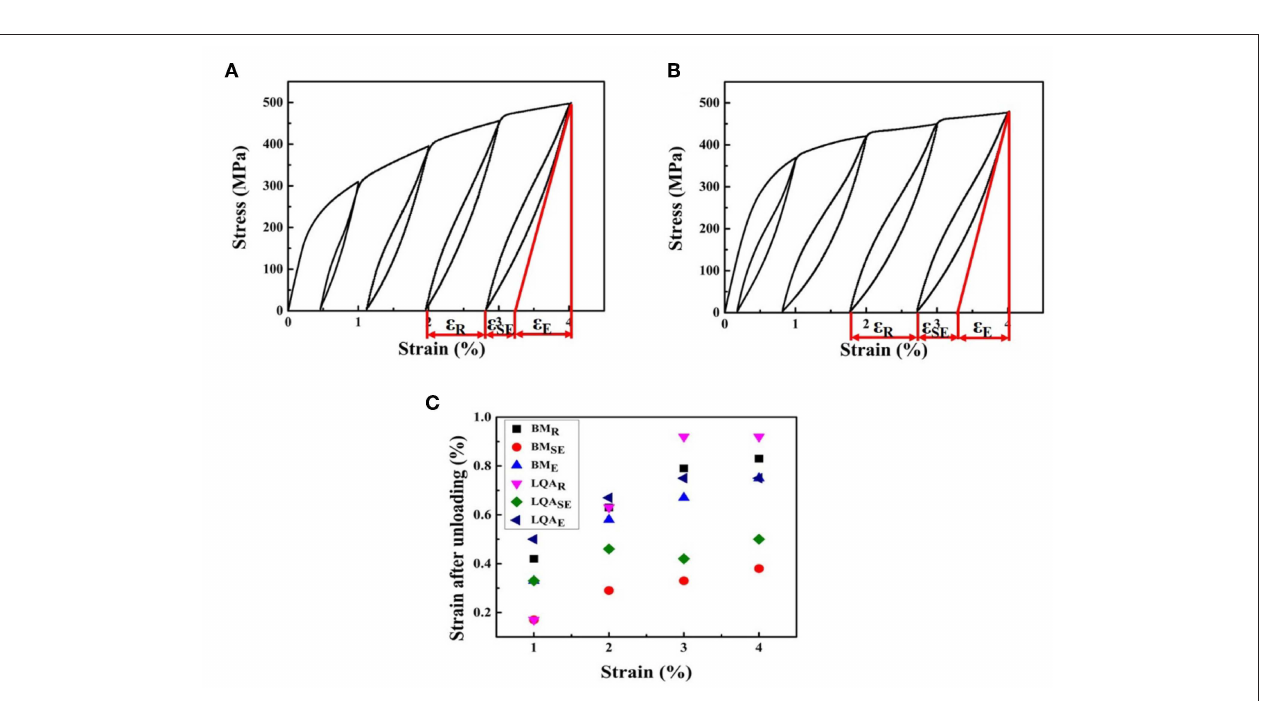
when the tensile strain is 4%. For laser quenched alloy, the maximum value measured is about 0.5% at the same tensile strain during superelastic recovery. Compared to the base metal, with the increase in tensile strain, the ε SE value is higher for laser-quenched alloy during superelastic recovery stage. The elastic recovery value can be intercepted by expanding the initial linear unloading stiffness [X] (strain) ( Wang et al., 2018). The elastic recovery value can be intercepted from X axis (strain) by extending the original linear unloading stiffness (Wang et